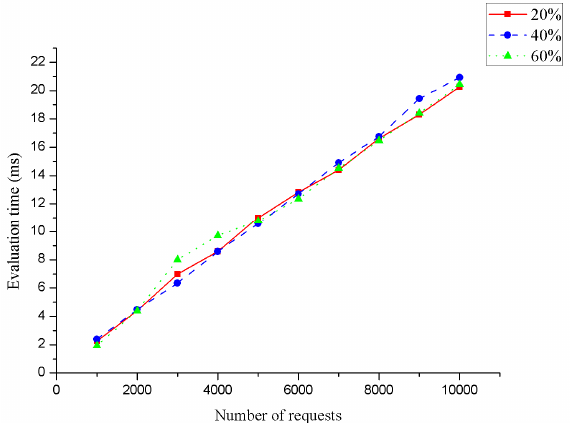
Figure 9. Evaluation performance under different interval rates.